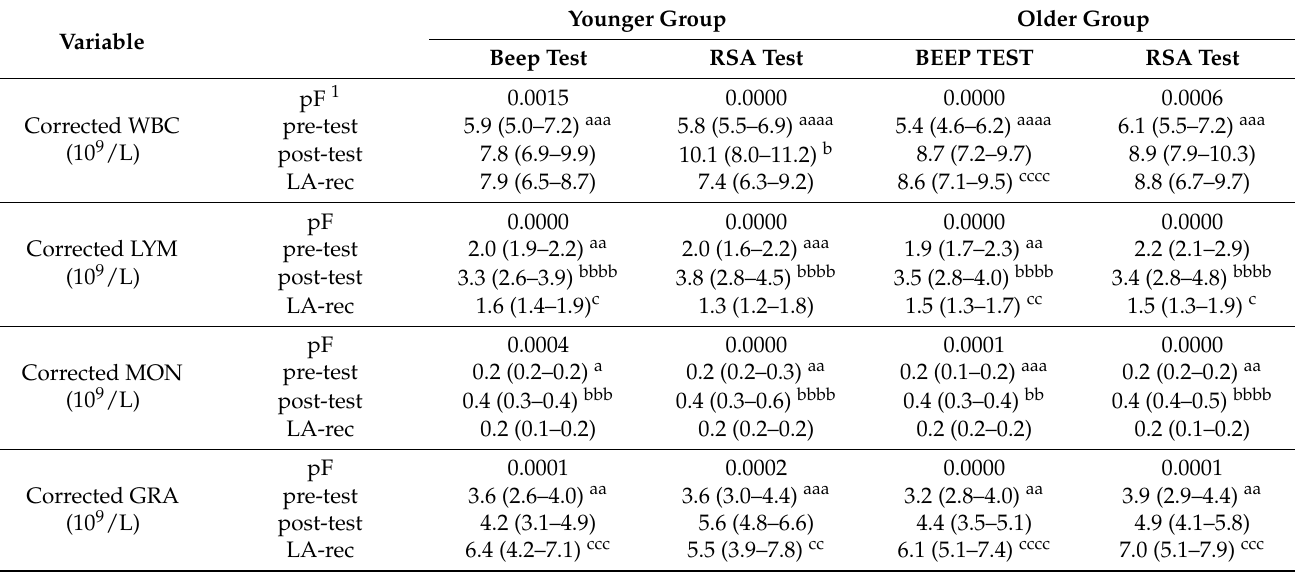
Table 6. WBC, LYM, MON, and GRA absolute counts corrected for ∆ PV in the peripheral blood of the participants at the studied time